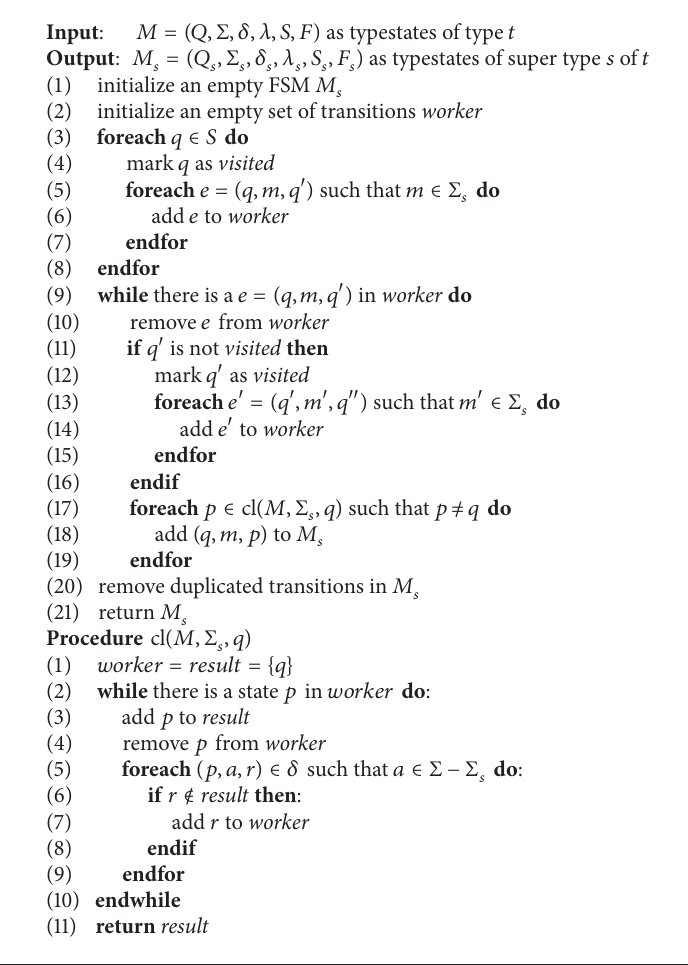
Algorithm 2: The algorithm to extract the typestates for a super type from the typestates of its implementing